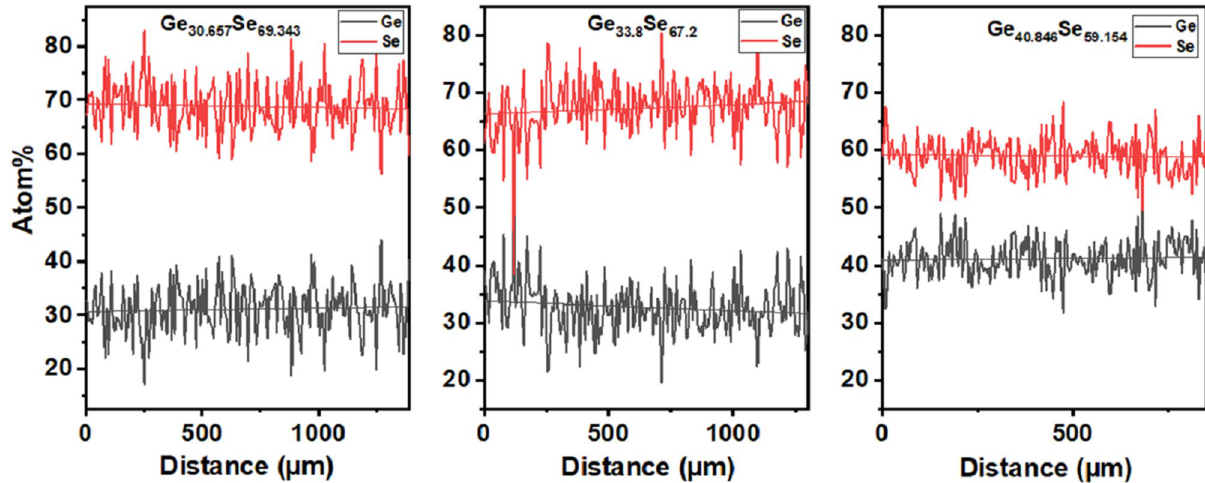
Figure 5. Line scan EDS of Ge 30 Se 70 , Ge 33 Se 67 and Ge 40 Se 60 printed